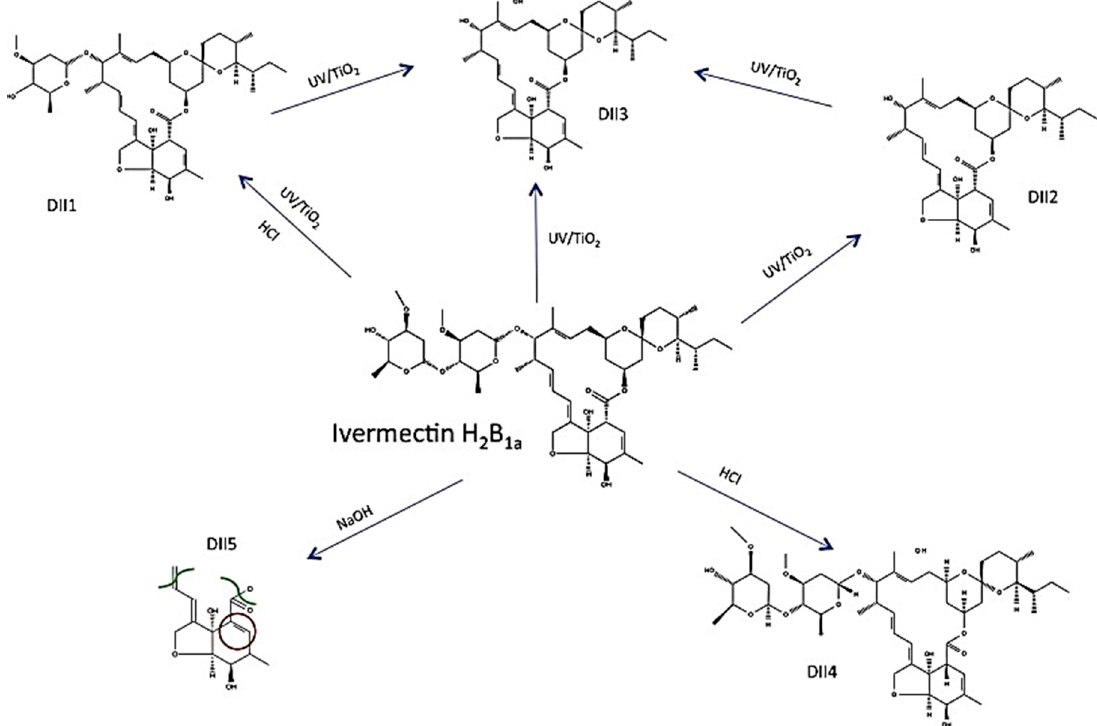
Figure 9. Ivermectin’s proposed degradation route. Reprinted/adapted with permission from Ref. [143]. Copyright 2016 Elsevier.